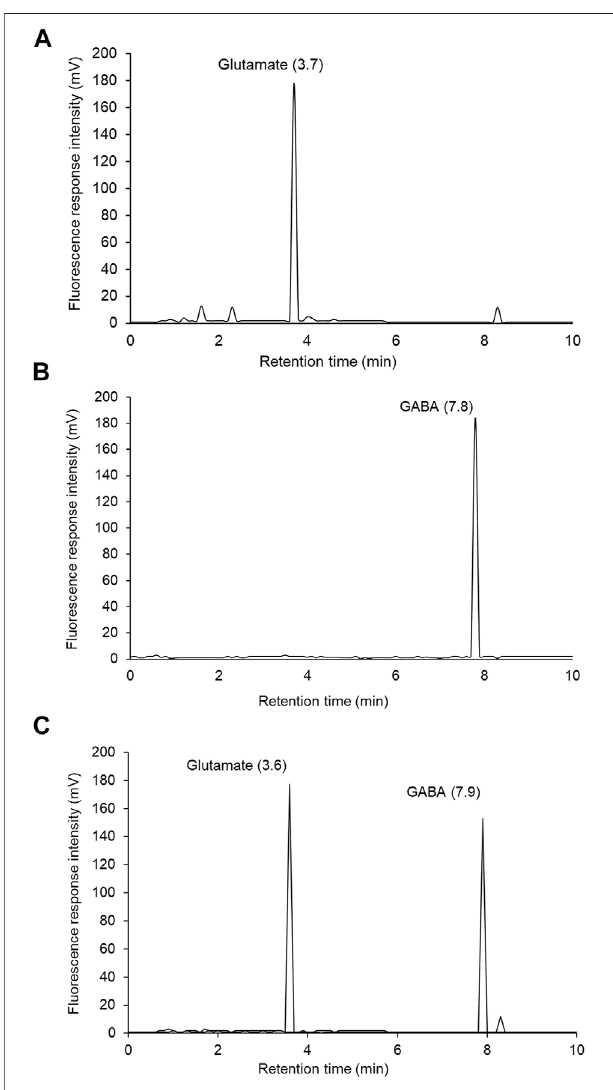
FIGURE 6 | Representative HPLC-FLD chromatograms of glutamate and GABA OPA derivatives: (A) glutamate standard solution (0.75 µg), (B) GABA standard solution (0.1 µg), (C) brain sample showing glutamate and GABA peaks.